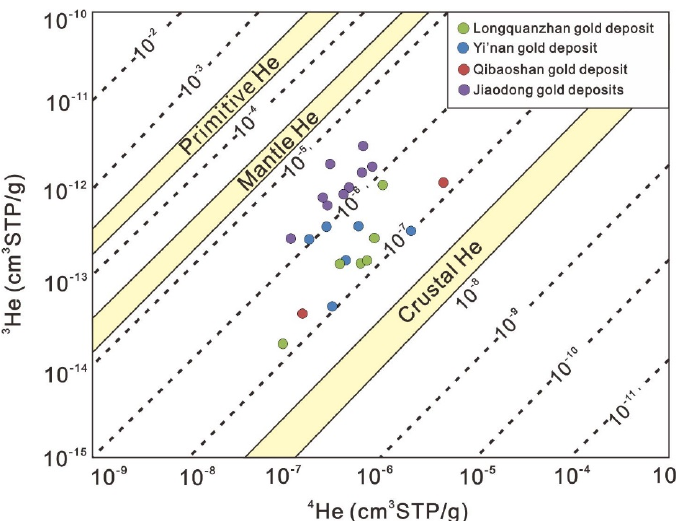
Figure 8. 4 He vs. 3 He diagram for ore fluid released from pyrite samples in the Longquanzhan, Yi’nan, Qibaoshan, and the Jiadong gold deposits. The He–Ar isotopic data for the typical Jiaodong gold deposits are from [44] and [45]. The He–Ar isotopic data for the Yi’nan gold deposits are from [4]. The 3 He/ 4 He ratios of the primitive He, mantle He, and crustal He fields are from [41].